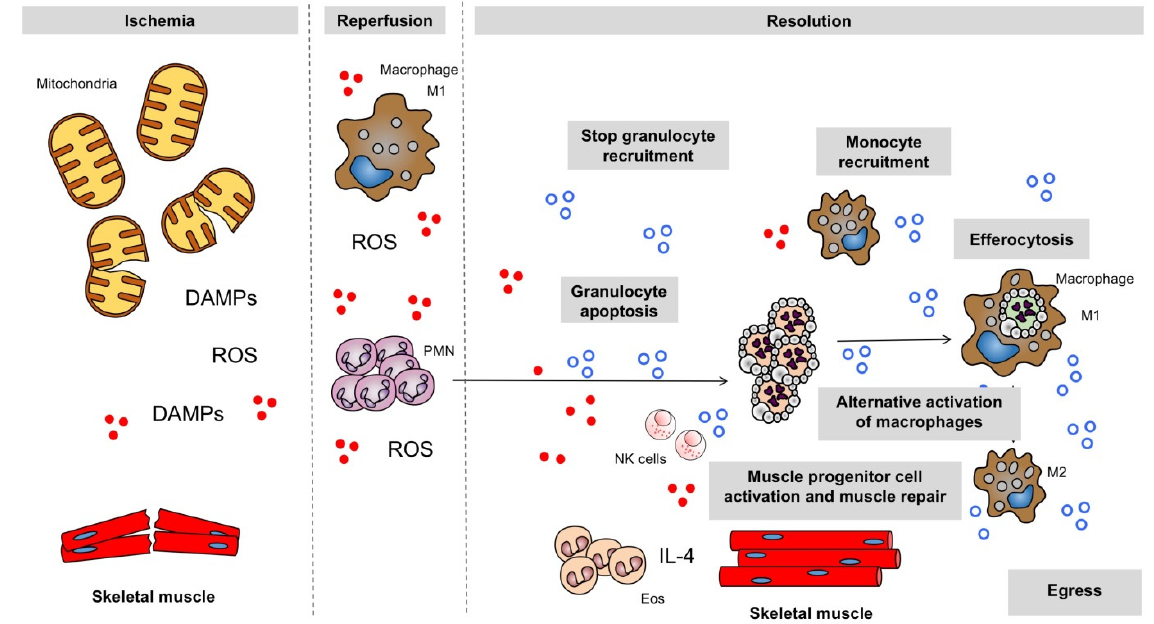
Figure 1. Resolution of inflammation in ischemia–perfusion injury in skeletal muscle.